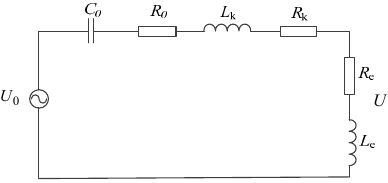
Figure 7. Equivalent model of the capacitor voltage transformer.